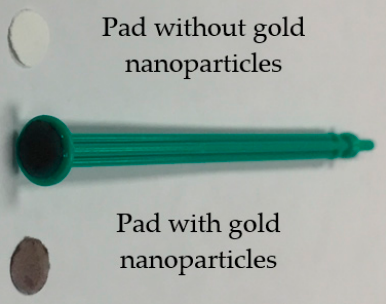
Figure 8. Photograph of the collection pads before and after immobilizing the gold nanoparticles, along with a rudimentary swabbing rod. The pads are ~5 mm in diameter.